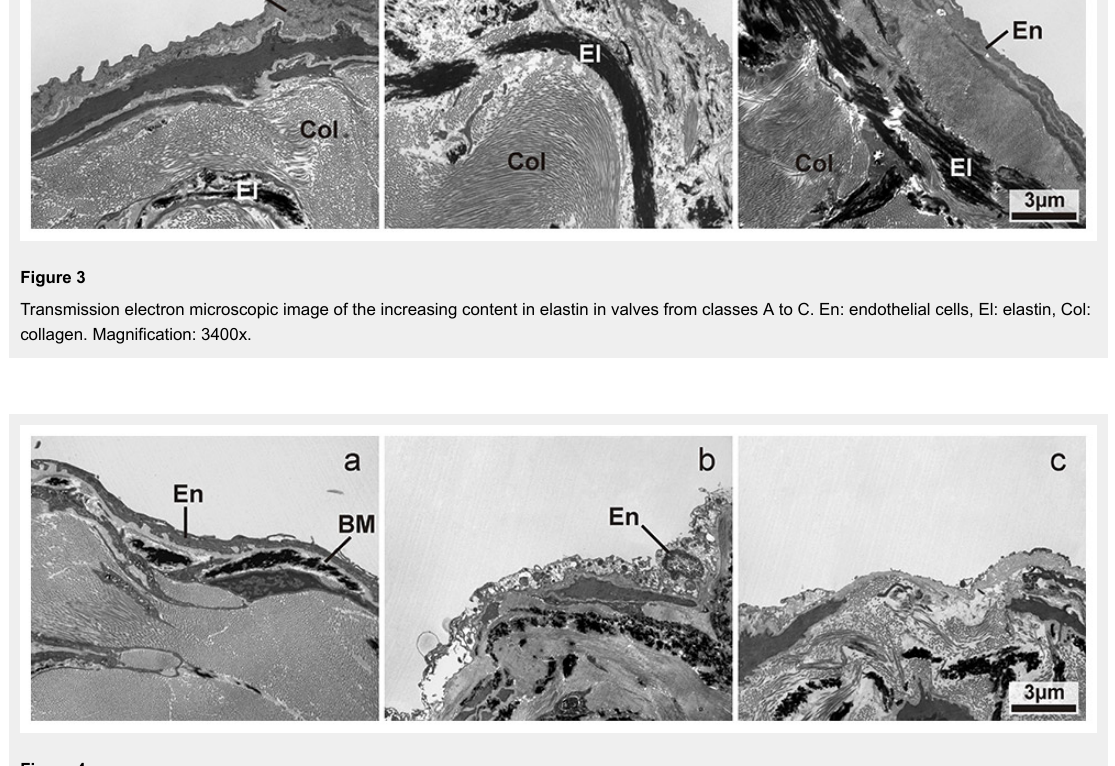
Figure 4 Transmission electron microscopic image of endothelial damage on the valve surface with increasing severity from a to c: a) normal endothelial cells; b) swollen and necrotic appearance of the endothelial cells; c) denuded valve surface with absent endothelial cells. En: endothelial cells, BM: basal membrane. Magnification: 3400x.